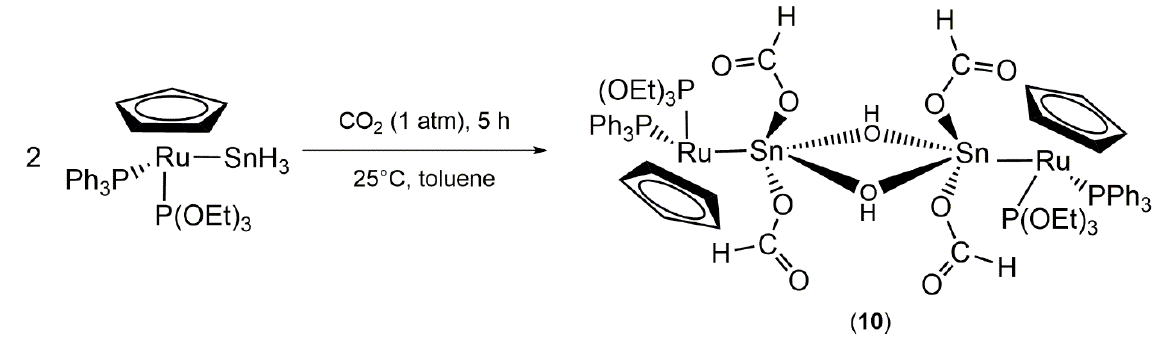
Figure 13. Molecular structure of 10 , adapted from [64] (MERCURY view). Hydrogen atoms are omitted for clarity except those of hydroxyl and formate groups (Ru blue green, Sn light blue, O red, P orange, C grey, H